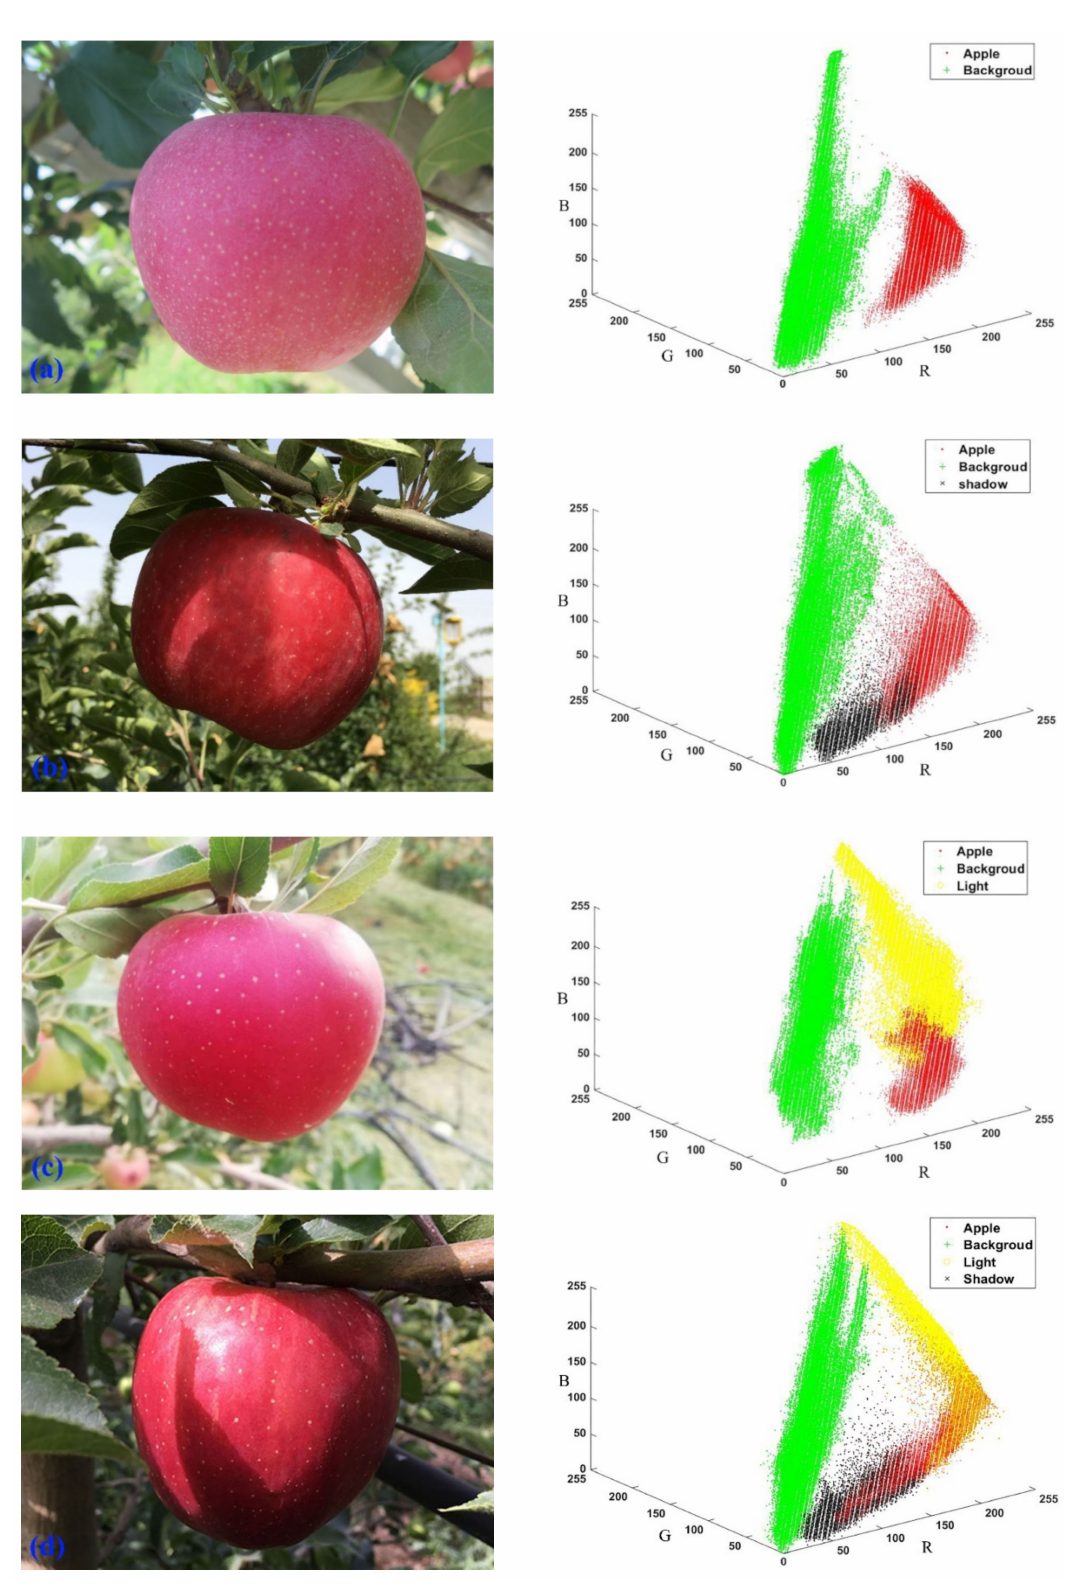
Figure 2. Extracted pixels in the RGB color space. ( a ) No halation and no shadows, ( b ) Only different degrees of shadows, ( c ) Only different degrees of halation at the edge of the apple surface, ( d ) Different degrees of both halation and